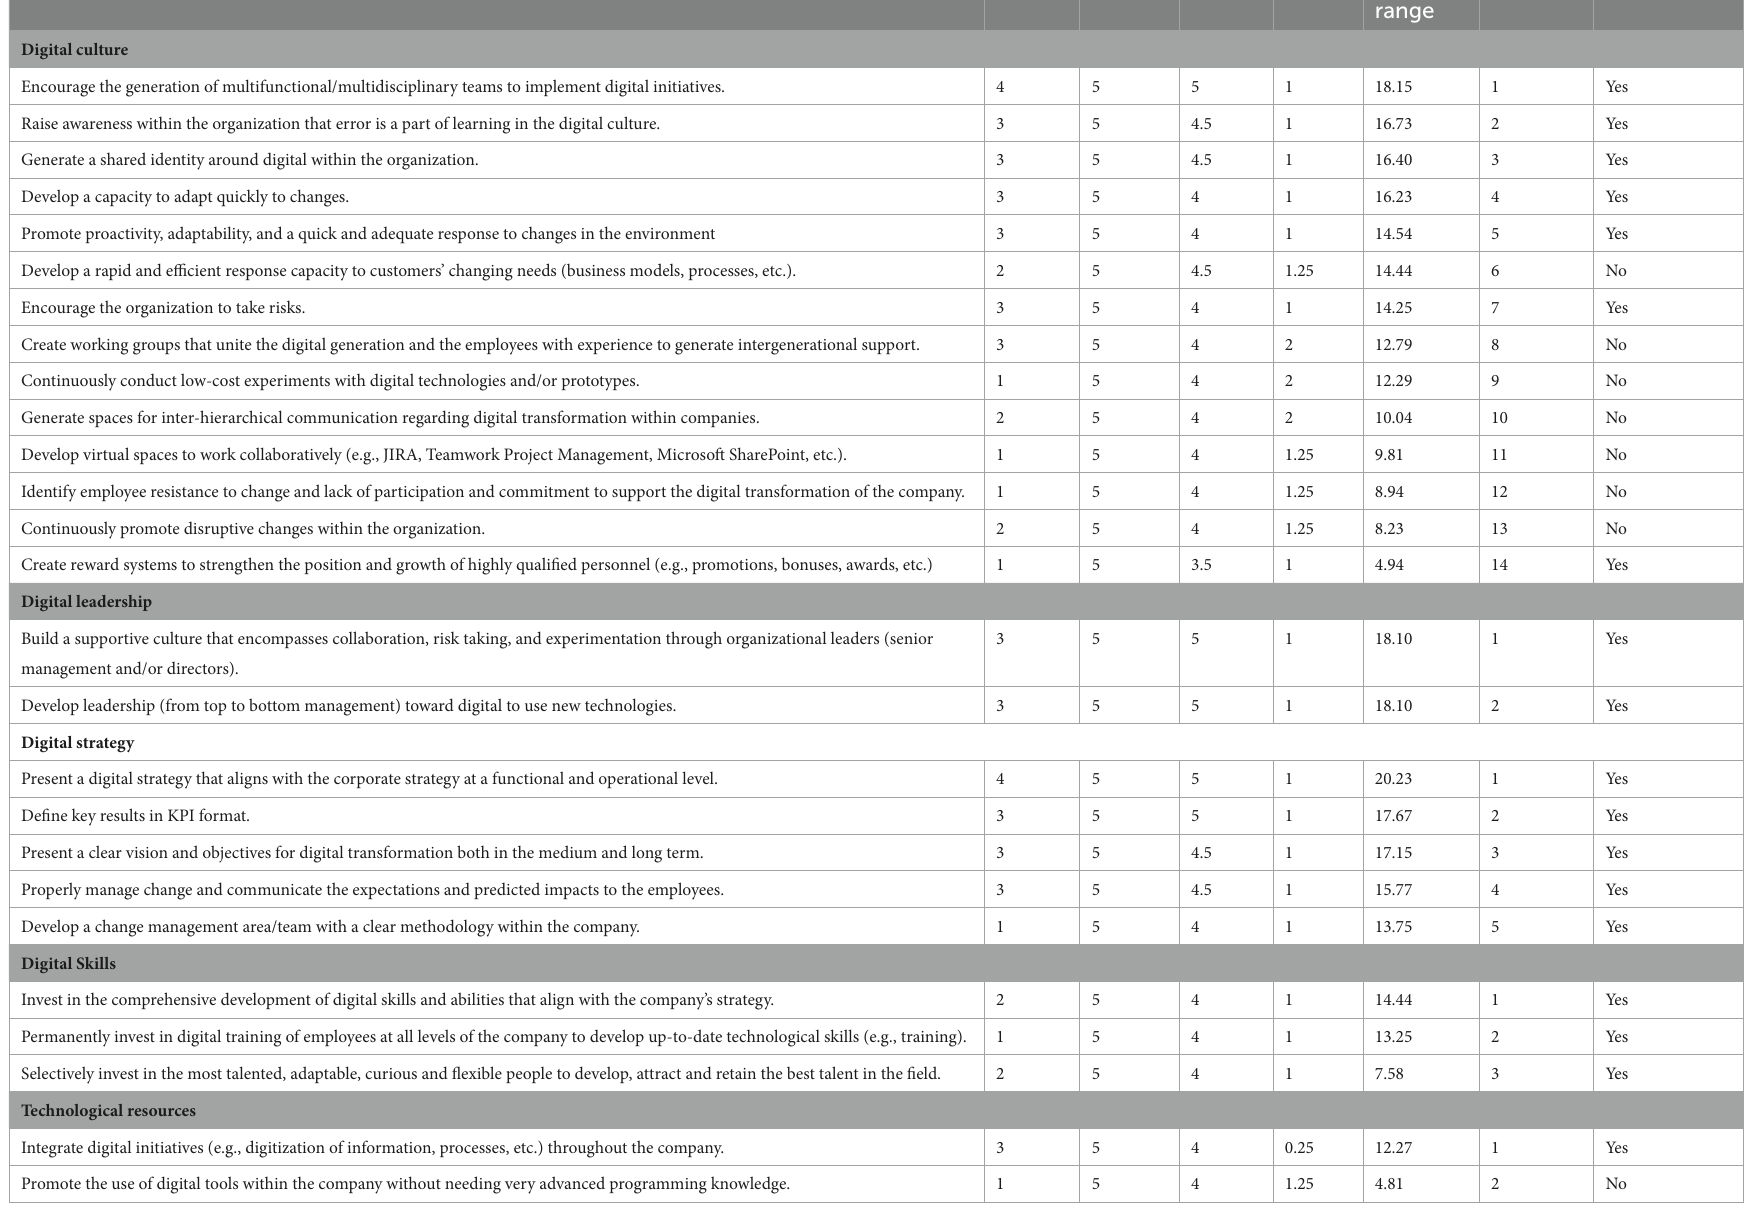
TABLE 3 Results for the second-round questionnaire. Factors Min. Max. Med. IQR Average